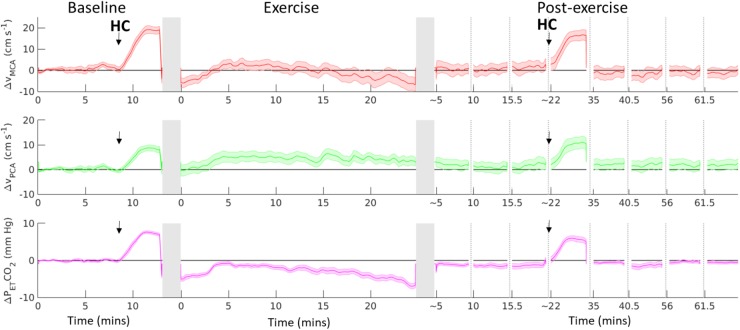
Change from baseline in MCA Vmean (red line), PCA Vmean (green line) and end-tidal CO2 (PETCO2, purple line), before, during and after 20-min of moderate-intensity aerobic exercise. Black arrow indicates start of a hypercapnia (HC) challenge. Dotted vertical lines indicates discontinuity in the data, gray vertical columns indicate where the participant transferred from supine position to/from the cycle ergometer. Black horizontal line represents supine baseline. Data shown are mean ± S.E.M.